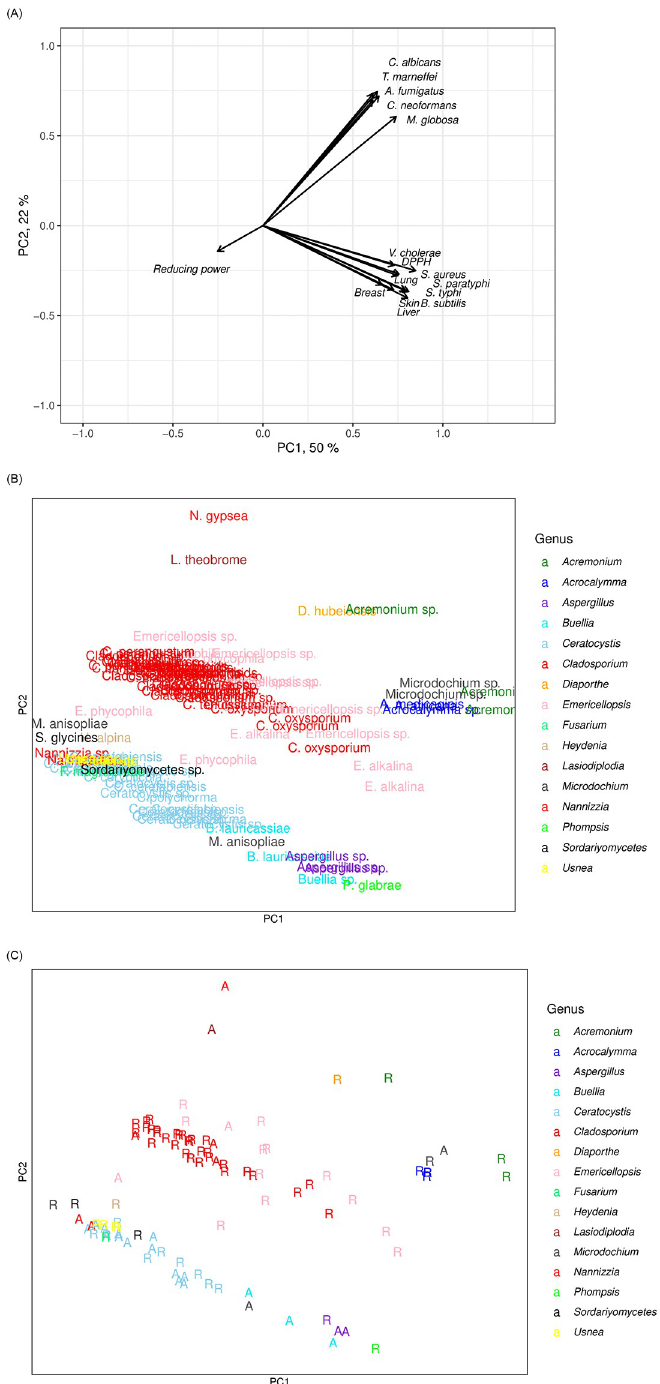
Fig 3. a. Loading’s of variables in PCA where marine fungal metabolites were measured for their inhibitory effect against bacteria, fungi, and cancer and their DPPH scavenging activity and reducing power. b. PCA sample score plot of marine fungal species. c. PCA sample score plot of marine fungal species marked according to their sampling location on the coast of the Red Sea (R) or the Arabian Gulf (A).